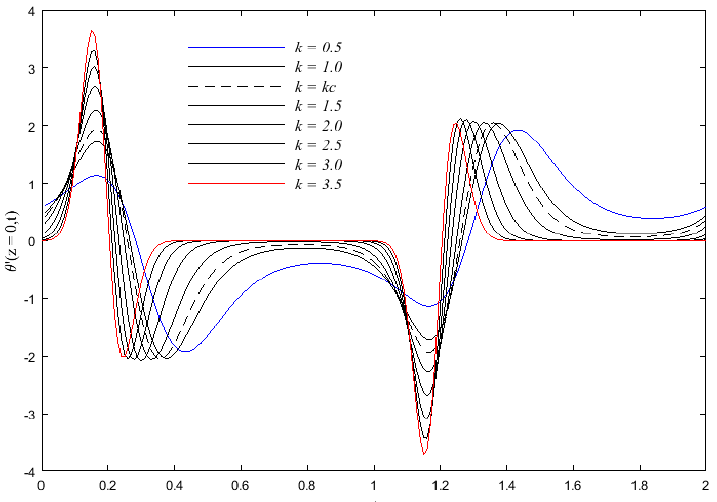
periods: k = 0.5 (blue); k = 1; k = k c (dashed); k = 1.5; k = 2.0; k = 2.5; k = 3.0; and k = 3.5 (red); where Ra takes the corresponding value from the neutral curve.